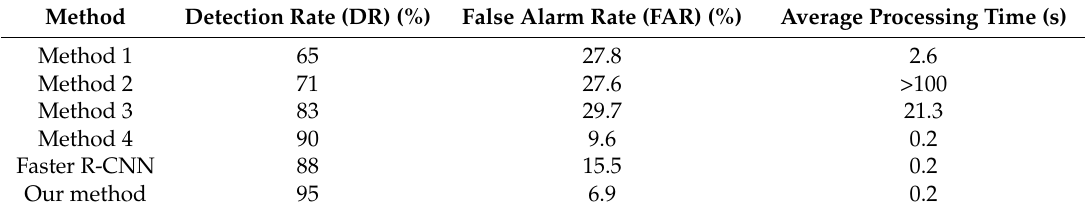
Table 2. Comparison of the results of different